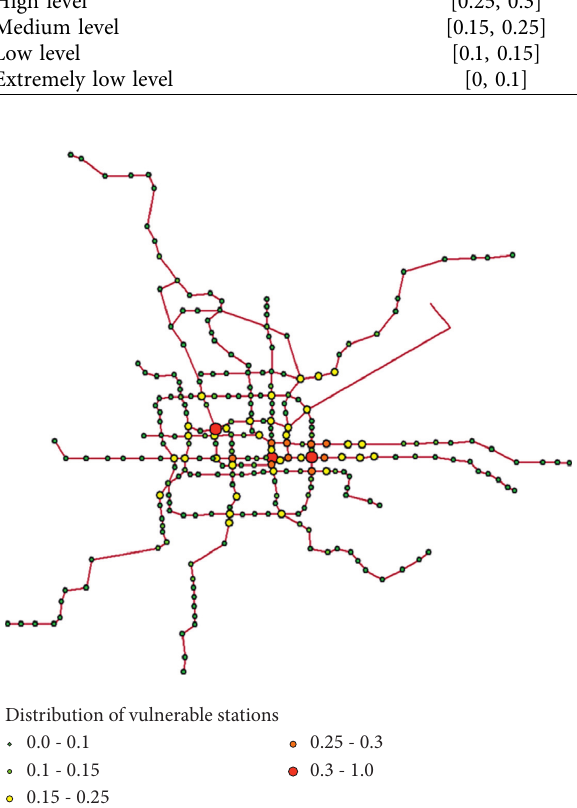
Figure 13: The distribution of vulnerability under cascading failure.